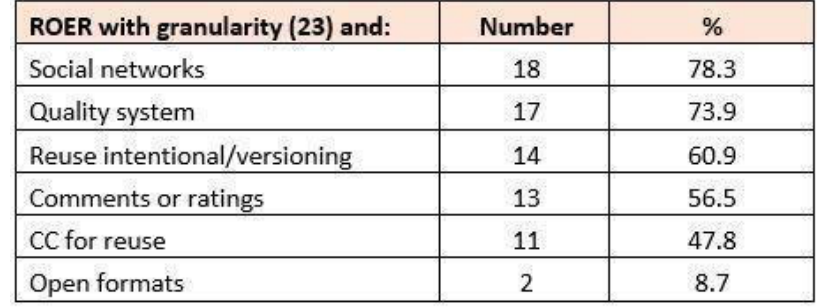
Indicators of Reuse in ROER with